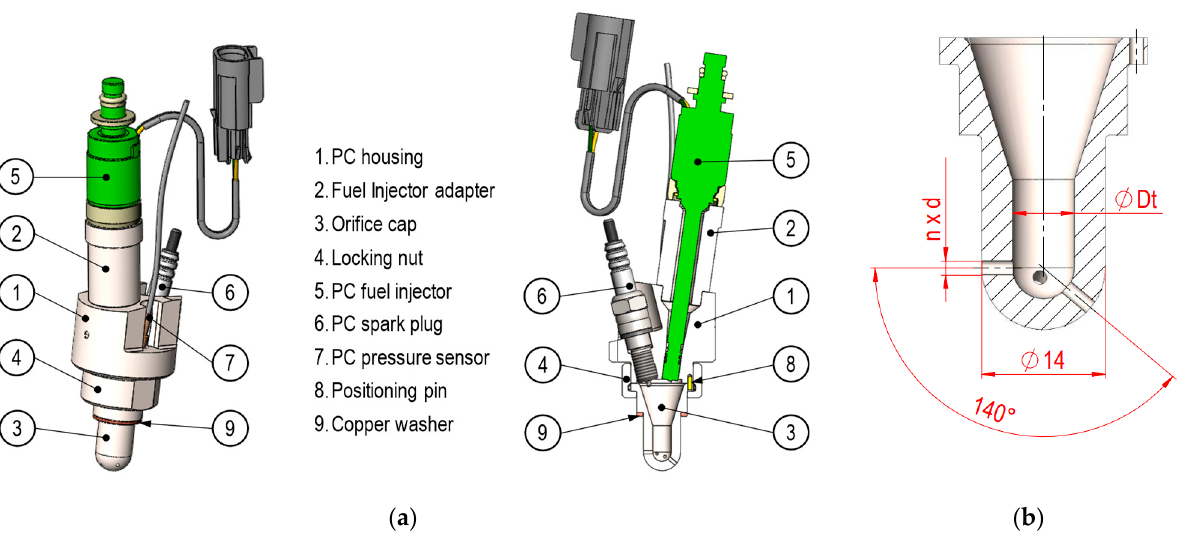
Figure 3. Pre-chamber ignition system: ( a ) pre-chamber system assembly; and ( b ) the orifice cap and its features (number of orifices ( n ), orifice diameter ( d ) and orifice throat diameter ( D t)) that define the pre-chamber geometry.